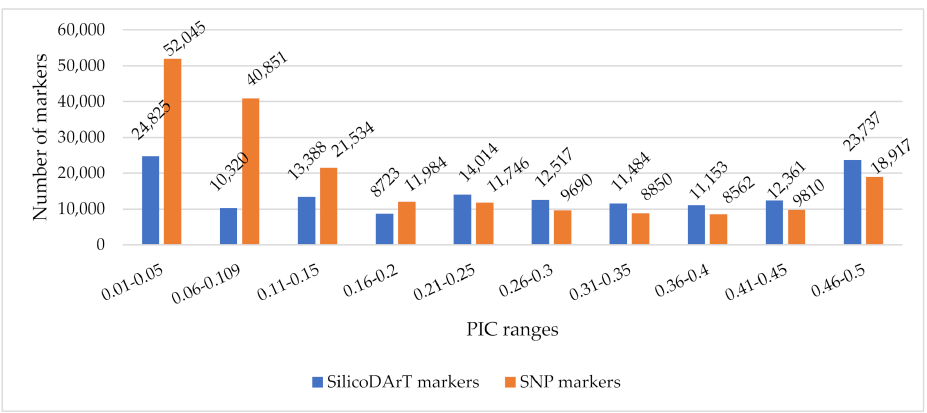
Figure 2. Number of markers by PIC values.